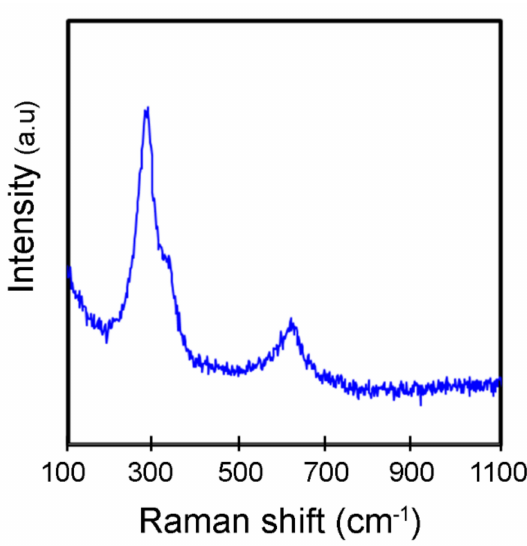
Figure 3. Raman spectrum of M. calabura derived CuO